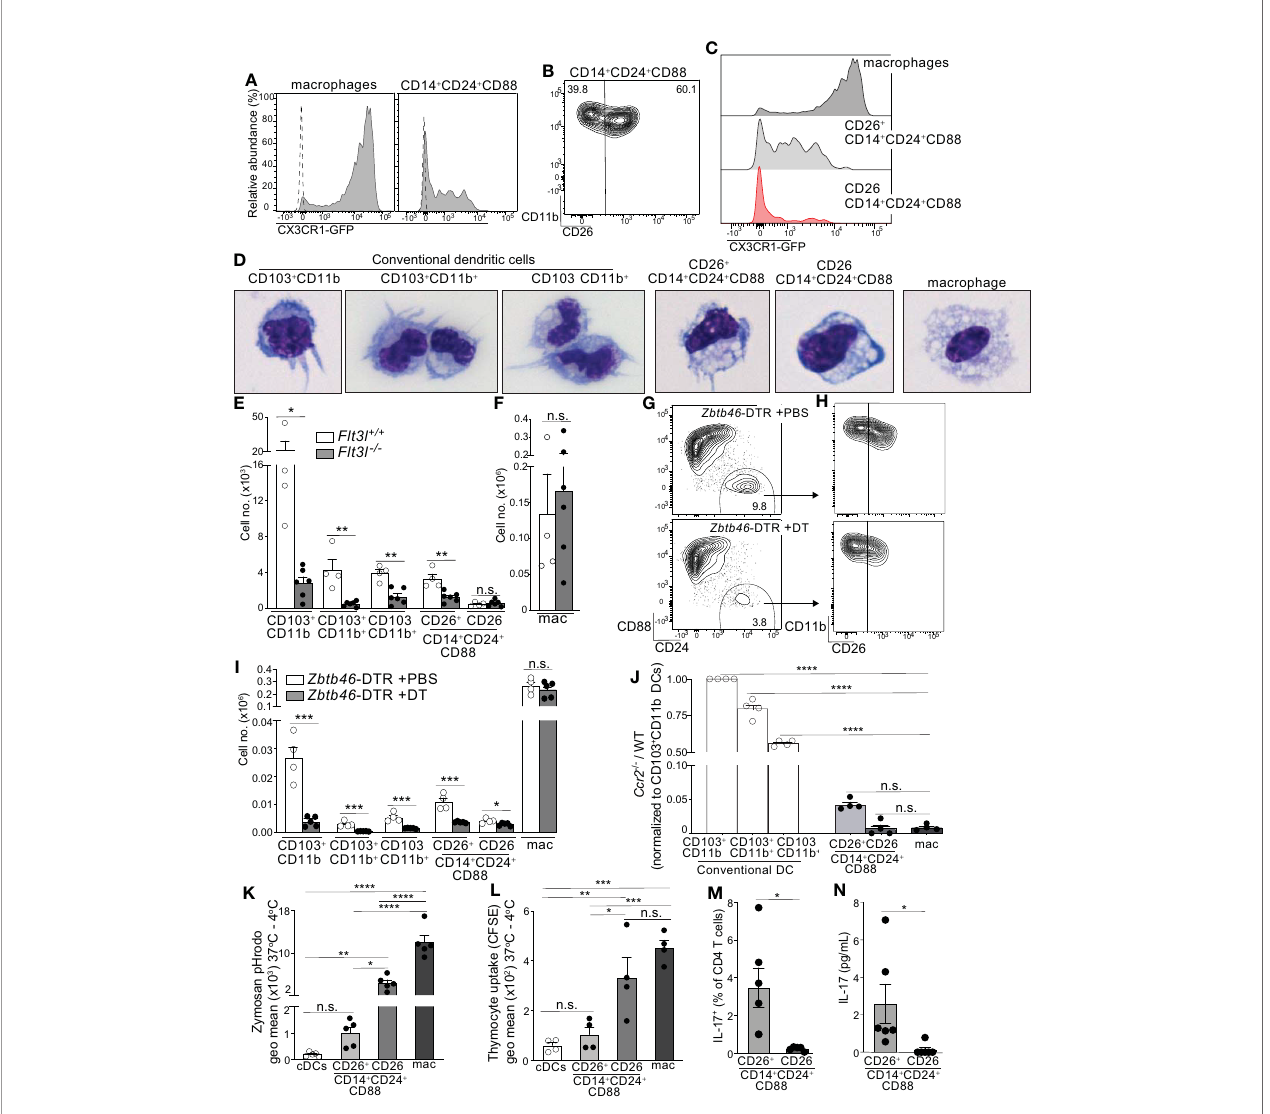
FIGURE 2 | Colon-speci fi c CD14 + CD24 + CD88 – APCs are composed of a CD26 + CX3CR1 int/neg cDC subset and an atypical CD26 – CX3CR1 – macrophage subset. (A) Representative histogram of CX3CR1-GFP expression by C-LP macrophages and CD14 + CD24 + CD88 – APCs (gated as in Figure 1V ). Dashed line represents GFP expression by the respective populations from wild-type, GFP negative control mice. (B) Representative plot of CD26 expression on C-LP CD14 + CD24 + CD88 – APCs. (C) Comparative CX3CR1-GFP expression by the indicated C-LP population. (D) Representative light microscopy image of sorted cells from the indicated C- LP mononuclear phagocyte subset. Data is representative of two independent experiments. (E, F) Absolute cell number of the indicated subset of C-LP mononuclear phagocyte (E) , and macrophages (F) in Flt3l +/+ and Flt3l – / – mice. Data was combined from two independent experiments. (G – I) Hematopoietic chimera reconstituted with Zbtb46 -DTR bone marrow were injected with diphtheria toxin (DT) to deplete Zbtb46 -expressing cells. Control chimera injected with PBS alone were analyzed in tandem. Representative fl ow plot gated as in Figure 1V indicating the relative abundance of CD14 + CD24 + CD88 – APCs (G) , the relative abundance of CD26 + and CD26 – subset among these APCs (gated in (G, H) , and the absolute number (I) of the indicated mononuclear phagocyte subset in PBS-treated or DT-treated mice. Data is representative of two independent experiments. (J) The ratio of Ccr2 -/- :wild-type (WT) cells within each of the indicated subset of C-LP mononuclear phagocyte from hematopoietic chimera reconstituted with a 1:1 ratio of WT and Ccr2 -/- bone marrow. Data is representative of two independent experiments. (K) The geometric (geo) mean of acidi fi ed Zymosan pHrodo ™ bioparticles within the indicated C-LP mononuclear phagocyte population after 1h incubation at 37°C. Fluorescence from cultures incubated at 4°C was subtracted. (L) The geometric mean of CFSE within the indicated C-LP mononuclear phagocyte population after 1h incubation with irradiated, CFSE labeled apoptotic thymocytes. CFSE fl uorescence from cultures incubated at 4°C was subtracted. Data in (K, L) is combined from three independent experiments. Each dot represents pooled cells from 3-5 mice. (M) Percentage of IL-17 + OT-II CD4 T cells, and abundance of IL-17 protein (N) in co-cultures with CD26 + or CD26 – subsets within CD14 + CD24 + CD88 – APCs, analyzed as in Figures 1W, X . Data in (M, N) is combined from four independent experiments each containing sorted APCs from at least 5 mice. Each dot represents one experiment or replicates within an experiment. Error bars represent mean ± SEM. * p < 0.05, ** p < 0.01, *** p < 0.001, **** p < 0.0001, n.s., not signi fi cant. (Statistical analysis for (J – I) was performed using one-way ANOVA with Tukey ’ s post hoc test. All other analyses were performed using unpaired Student ’ s t